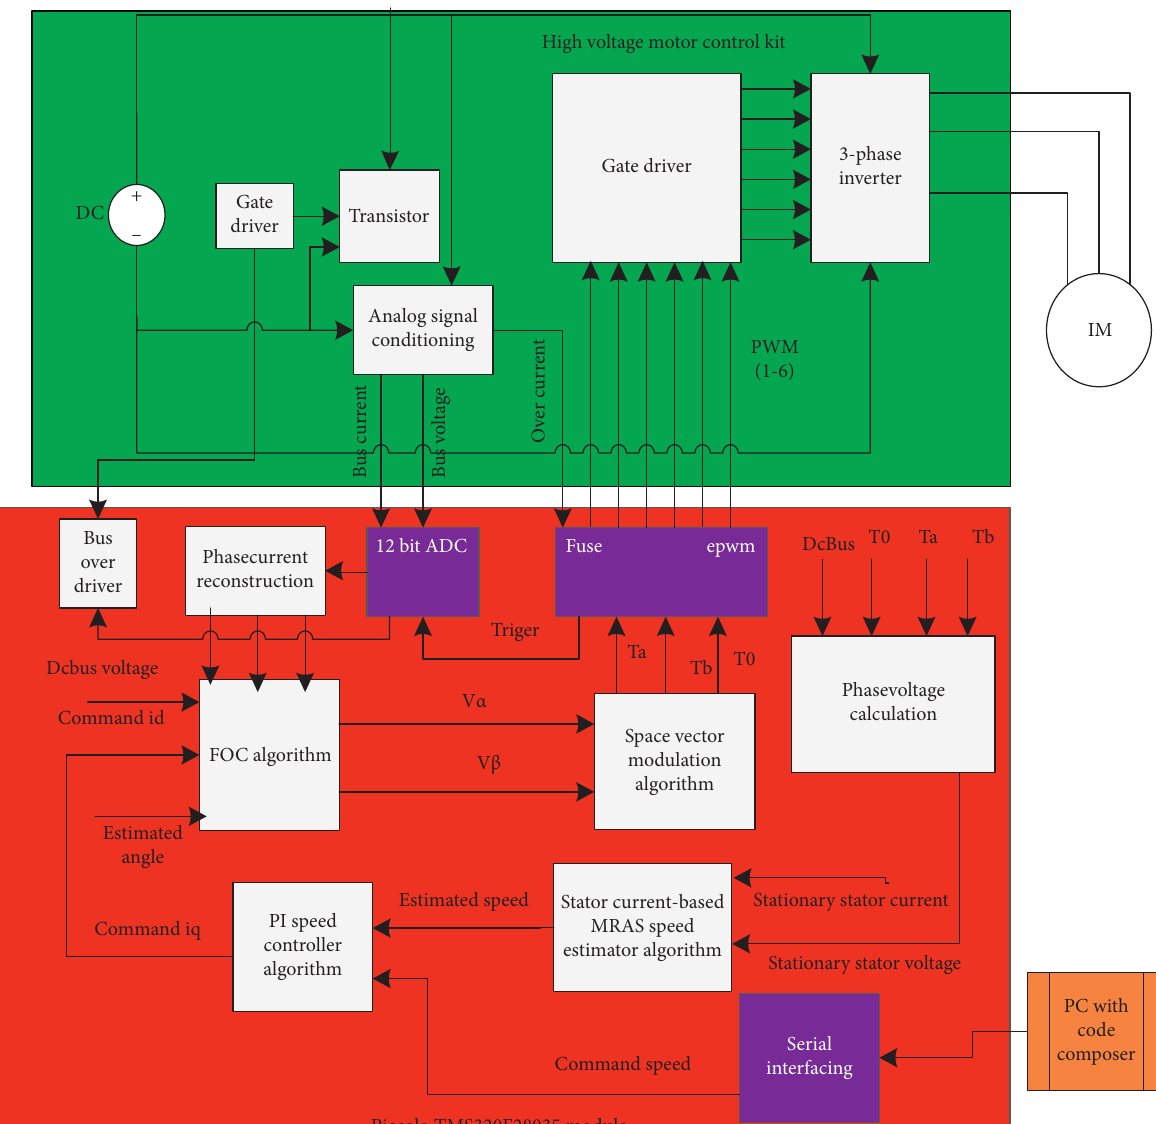
Figure 22: Experimental block diagram for MRAS-based sensorless speed control of the